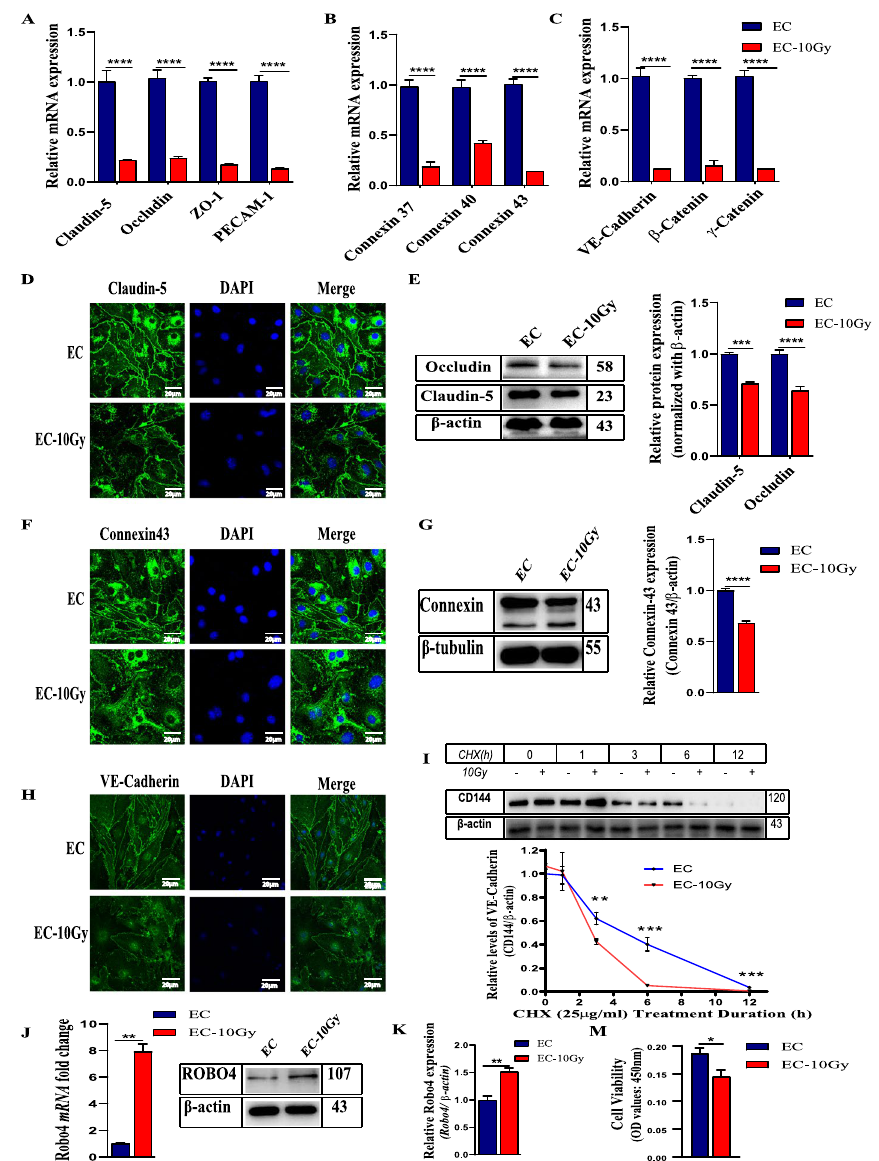
Fig. 1 IR decreases the expression of EC junctional molecules but upregulates Robo4 expression. A–C RT-qPCR shows the relative mRNA expression of the TJs, GJs, and AJs. Gene expression results were normalized to glyceraldehyde-3-phosphate dehydrogenase (GAPDH) and beta-actin endogenous control and represented as fold change in gene expression. The error bars stand for the standard deviation from three separate independent experiments. D and E Detection of TJs (claudin-5 and occludin) protein expression by immunocytochemistry and western blot, respectively. F and G Analysis of gap junction (connexin 43) protein expression using immunofluorescence and immunoblotting. H and I The distribution and expression of VE-cadherin analysis with immunofluorescence, cycloheximide chase experiment, and western blot. J and K mRNA and protein detection of Robo4 in microvascular ECs after irradiation using RT-qPCR and WB. M Effect of irradiation on cell survival and proliferation of ECs. For all experiments, scale bars bars represent std. * P < 0.05, ** P < 0.01, *** P < 0.001, **** P <